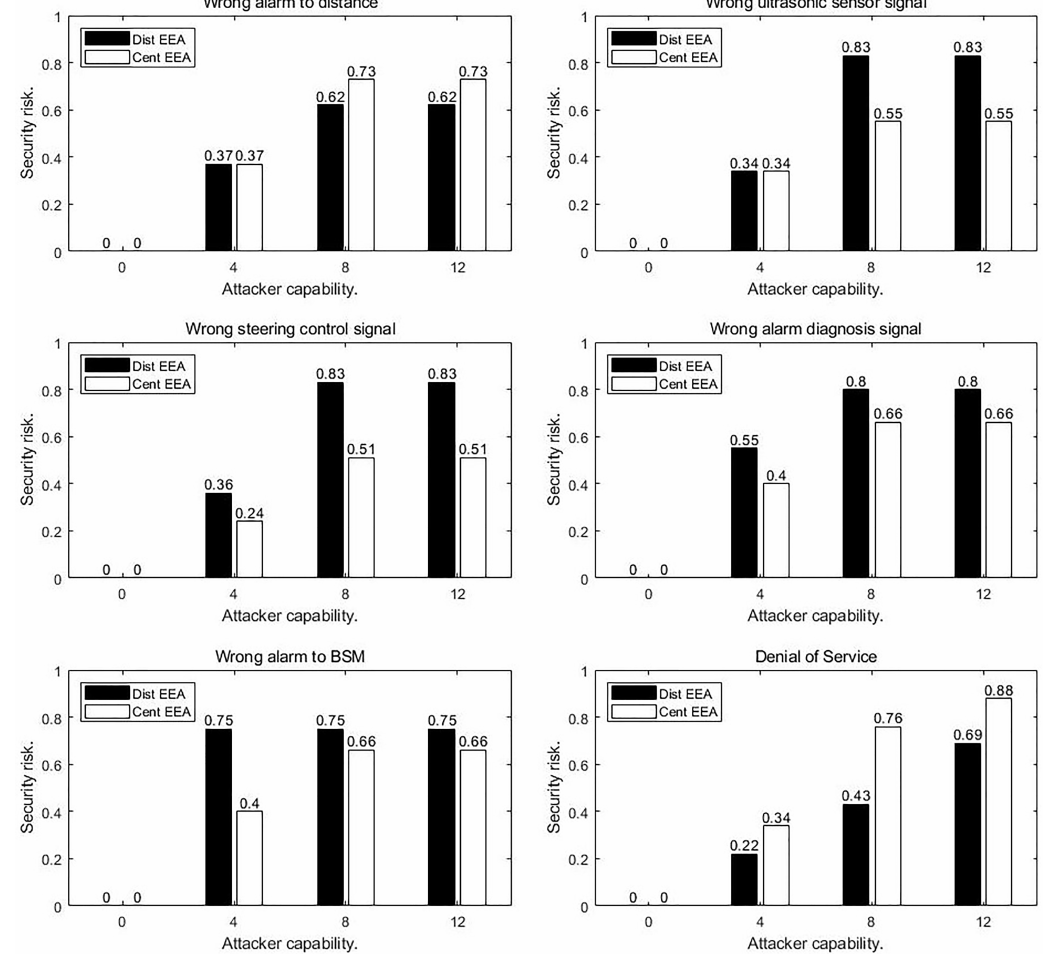
Figure 9. Evaluation